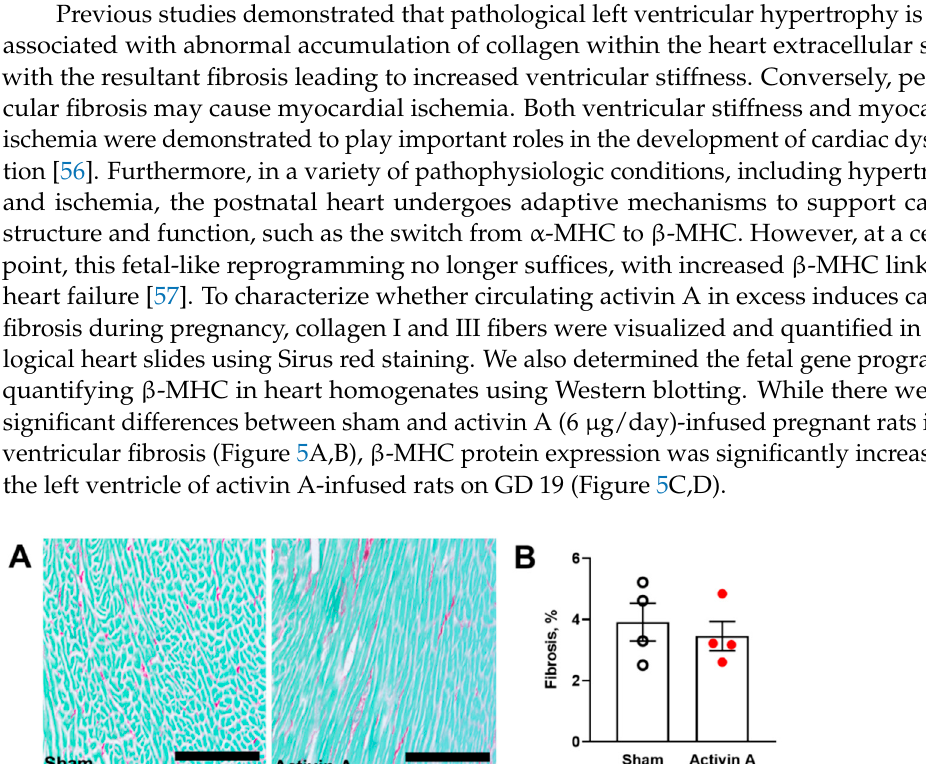
Figure 4. Cardiac parameters. Ejection fraction (EF; ( A )); and fractional shortening (FS; ( B )); measured on gestational day 19 in sham (open black circles) and activin A-infused (6 µg/day; solid red circles) pregnant rats. Data are mean ± SEM.